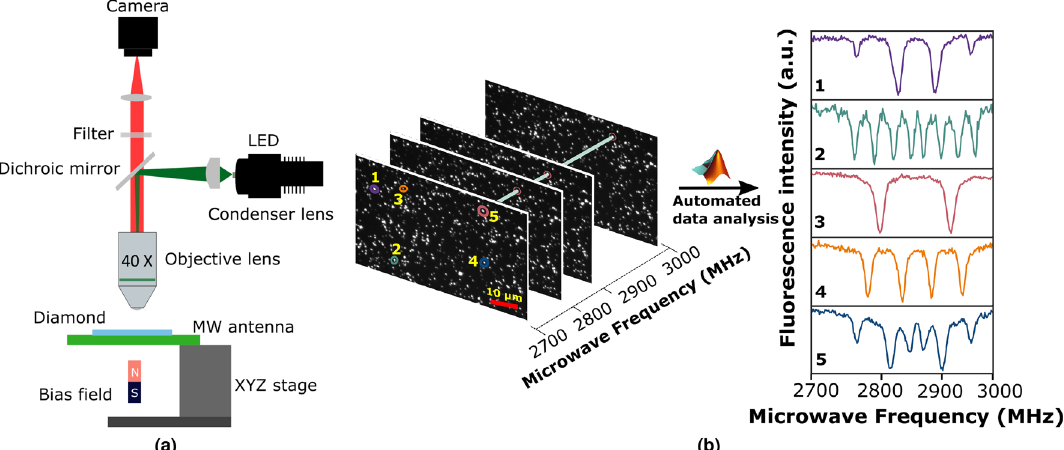
Figure 1. ( a ) Schematic of the wide-field diamond magnetometer used for the described magnetic field sensing and imaging. ( b ) Layout of the volumetric image data from the ODMR imaging measurement, where a total of N frames are obtained by sweeping the microwave frequency around 2.87 GHz with rows and columns of pixels that form 2D slices with N frames that form the volume. The ODMR signal is obtained by averaging n pixels (indicated in blue) in the pixel region. The original volumetric data contain the ODMR spectrum for each diamond spot. Plot of ODMR spectra extracted from the image data using the automated algorithm for five different diamond spots (numbered 1 to 5). Each of the diamond crystals is oriented at different angles with respect to the magnetic field